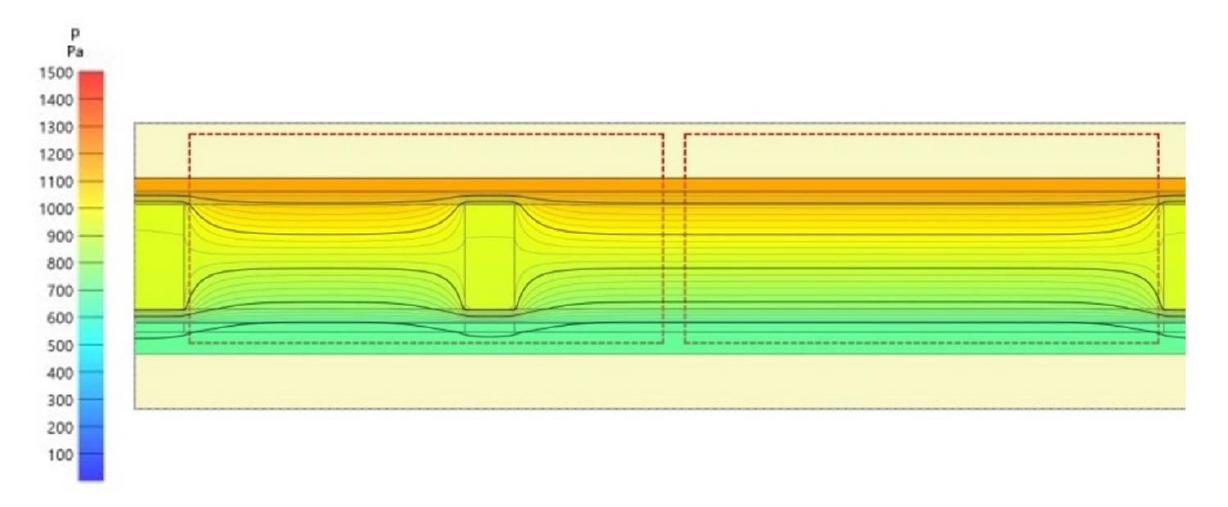
Figure 8. Theoretical simulation display of the timber wall’s water vapor pressure. The temperature deviation between the two surfaces of the timber wall creates water vapor that accumulates in its body. Figure 9 exhibits a greater increase of water vapor (dark red color) on the surface of the timber stud, with a smaller accumulation in the inner part of their contact with the thermal insulation material. In the middle part of the timber frame masonry, a very low level of vapor is visible (which is displayed with the light blue color).